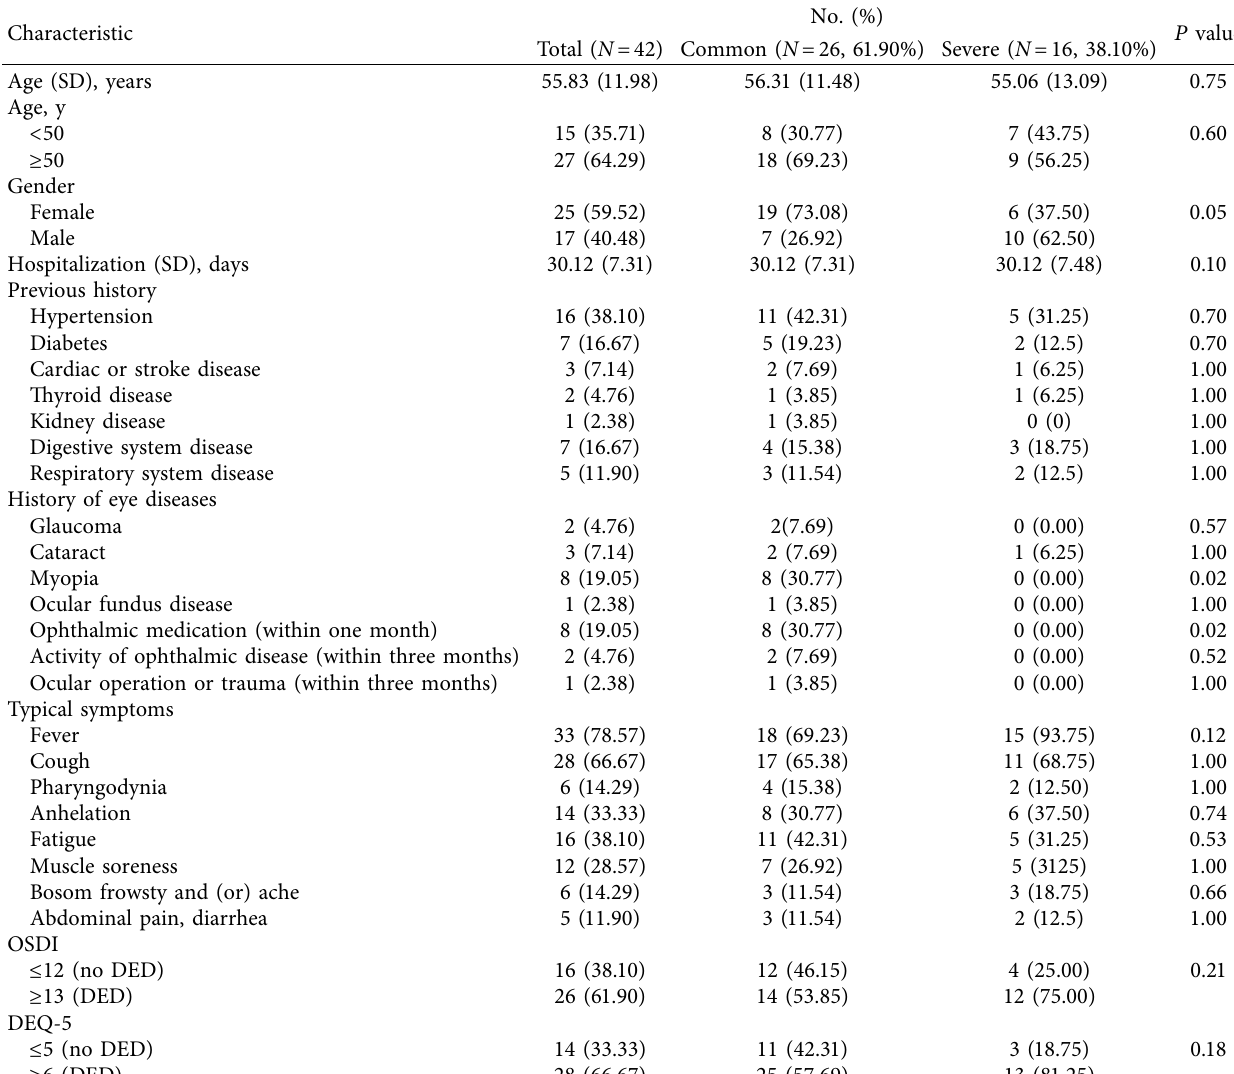
Table 1: The characteristics of patients with